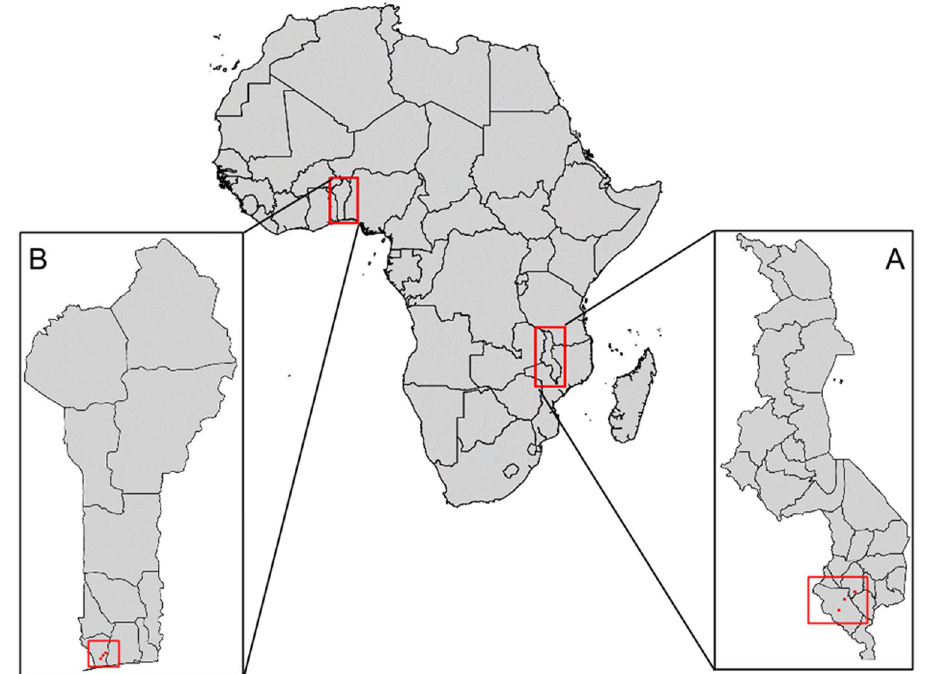
Figure 2. Study sites in ( A ) Malawi and ( B ) Benin. The map was created with RStudio, version 0.98.1083, https://www.rstudio.com/.